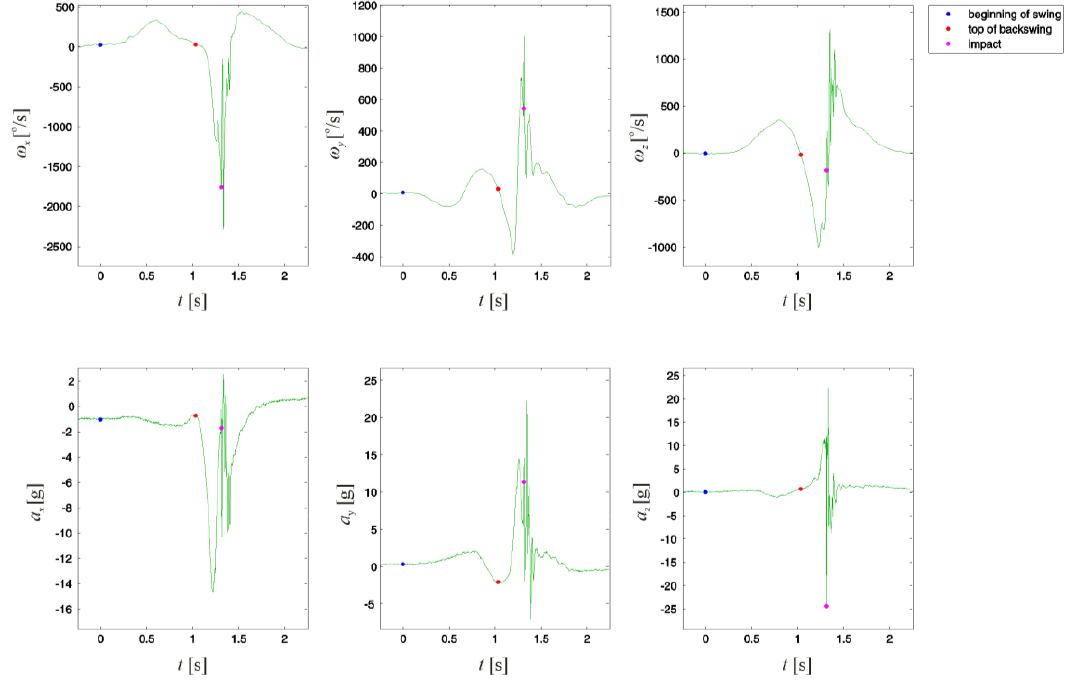
Figure 3. Golfer’s leading arm angular velocities ω and a for one extracted swing sequence obtained using a wearable 3D motion sensor. The z sensor-intrinsic x axis coincided with the longitudinal axis of the golfer’s leading arm, while the y and z axes referred to the lateral and vertical arm axes,